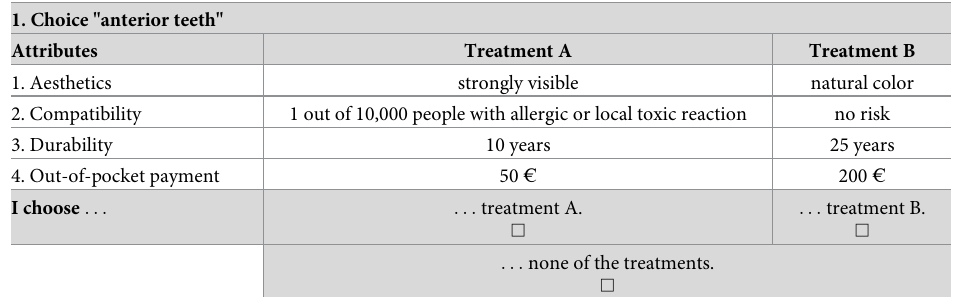
Table 2. Example of choice